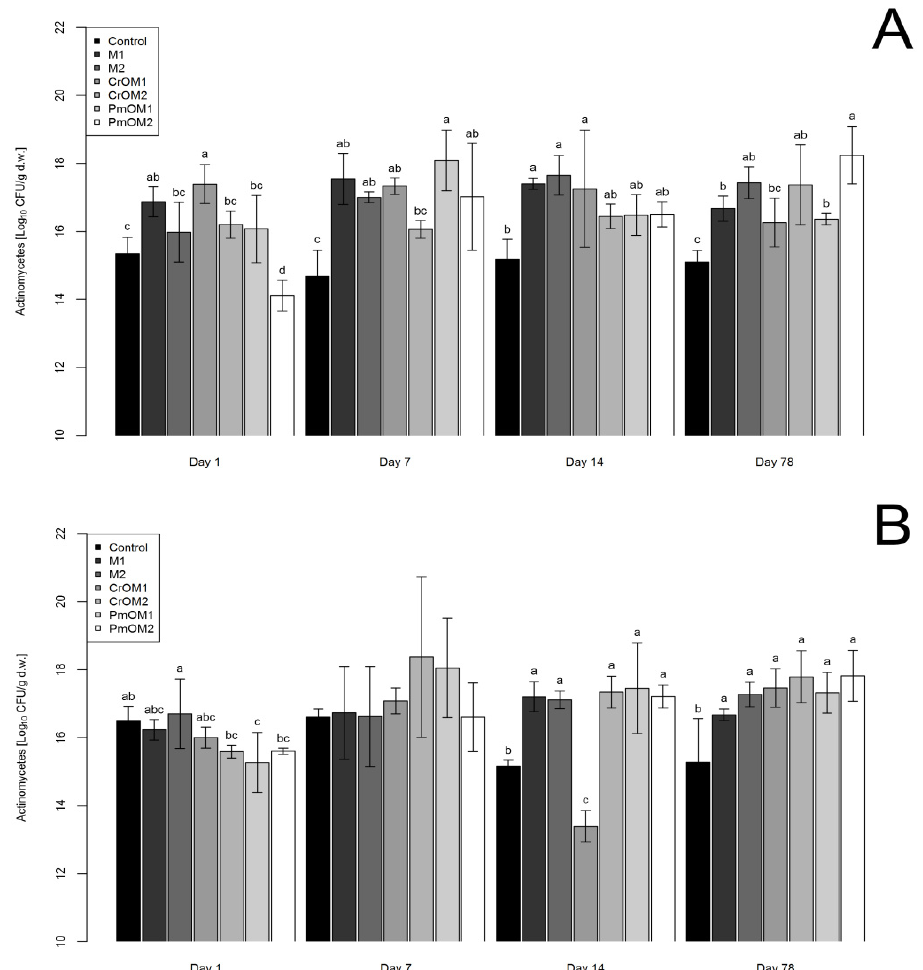
Figure 3. The abundance of actinomycetes in sandy ( A ) and loamy ( B ) soils depending on different treatments with maltodextrin (M1 and M2) and encapsulated essential oils of caraway (CrOM1 and CrOM2) and peppermint (PmOM1 and PmOM2). 1 and 2 refer to doses of microcapsules, 50 and 200 g per 1 kg of soil, respectively. Letters on error bars denote statistical significance among groups according to Duncan’s MLR post hoc test at level p < 0.05.